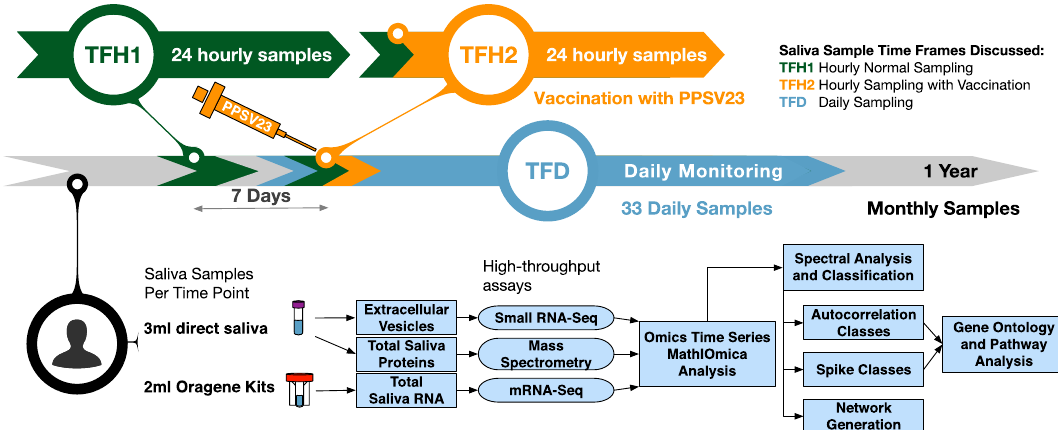
Figure 1. Study overview. The study followed an individual over the span of a year, collecting 100+ saliva samples. In this manuscript we discuss three time frames of interest for saliva sampling: (1) TFH1, where 24 hourly samples were taken, (2) TFH2, where 24 hourly samples were taken but the subject was also vaccinated with PPSV23 during this time frame, (3) TFD, where daily samples were taken. At each timepoint unstimulated saliva was collected (at a rate ∼ 500 µ l/min ). 3 ml of saliva were stored directly and subsequently used to extract extracellular vesicle RNA, and proteins for mass spectrometry proteome profiling. Furthermore, 2 ml saliva was collected with Oragene (DNAGenotek) kits, which contain a stabilizer, and used to profile total saliva transcriptomics using RNA-sequencing; see “Methods” for further collection and processing details. The data were used to generated time series with MathIOmica , which revealed multiple trends corresponding to response to immunization with